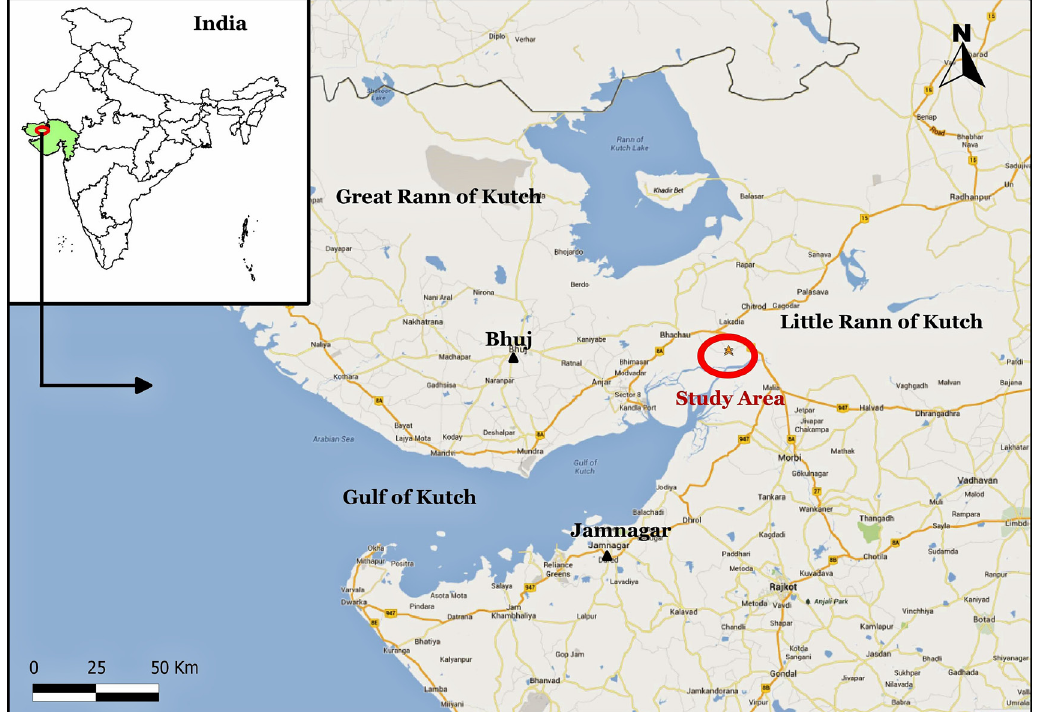
Figure 1. Map of India and Gujarat showing study